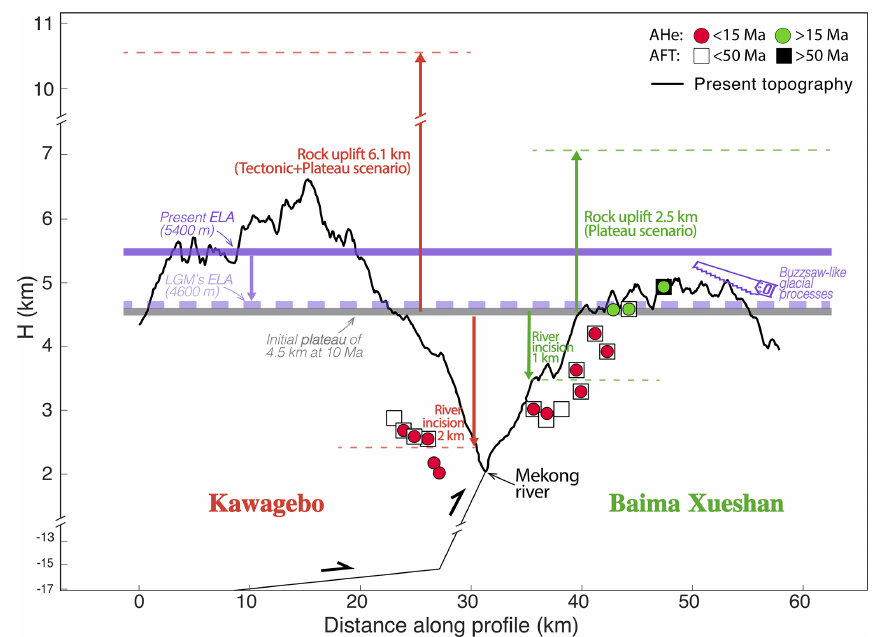
Figure 7. Exhumation since ∼ 10Ma for the Kawagebo (red arrows) and Baima Xueshan (green arrows) massifs; with inferred Mekong river incision (downward red/green arrows) from scenarios with a schematic plateau at 4.5km (horizontal grey thick line). Purple dotted thick line marks the glacial equilibrium line altitude (ELA) during the Last Glacial Maximum (LGM; ∼ 20ka) (Fu et al., 2013), at which glacial erosion is most effective. Glaciation allows the formation of low-relief surfaces at high elevation through buzzsaw-like processes in Baima Xueshan, where rock exhumation is relatively low compared to the Kawagebo massif. Note that the geometry of the west-dipping thrust along Mekong river is not scaled at